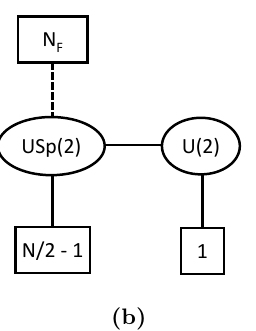
Figure 29. (a): the quiver diagram read off from figure 28b. (b): the quiver diagram read off from figure